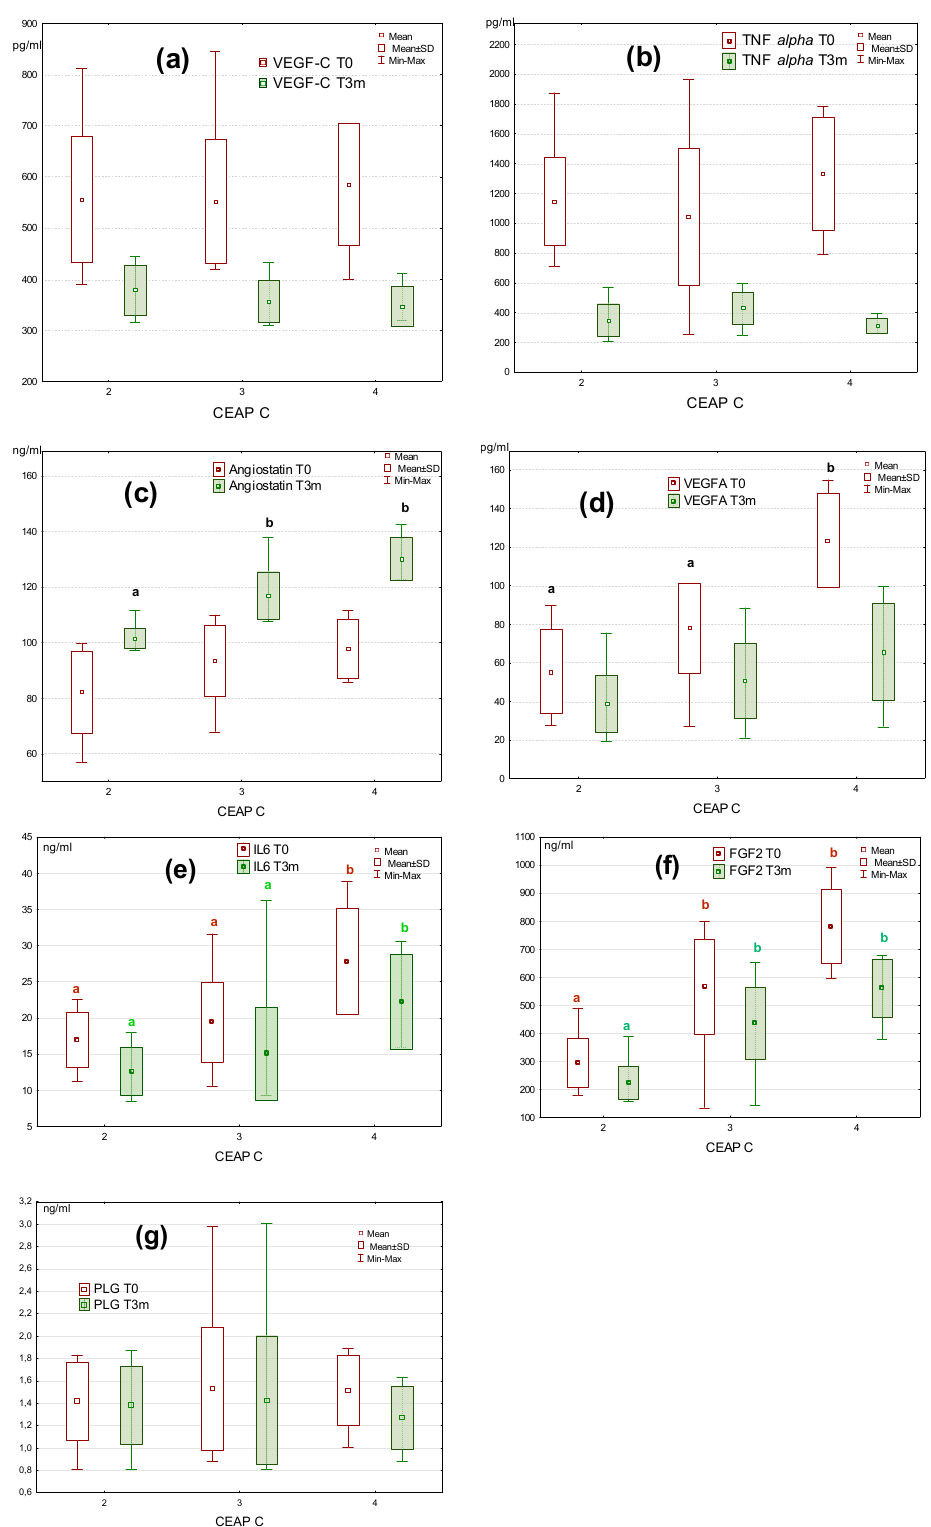
Figure 3. Comparison of the levels of the investigated factors in the C2, C3, and C4 groups before (T0) and after three months of diosmin treatment (T3m). The data followed by the di ff erent letters are statistically significant: ( a ) and ( b ) lack of statistically significant di ff erences ( p > 0.05), ( c ) p = 0.005 for C2 and C3; p = 0.0001 for C2 and C4; ( d ) p = 0.05; ( e ) p = 0.01 for C2 and C3; p = 0.001 for C2 and C4; ( f ) p = 0.01 for C2 and C3; p = 0.001 for C2 and